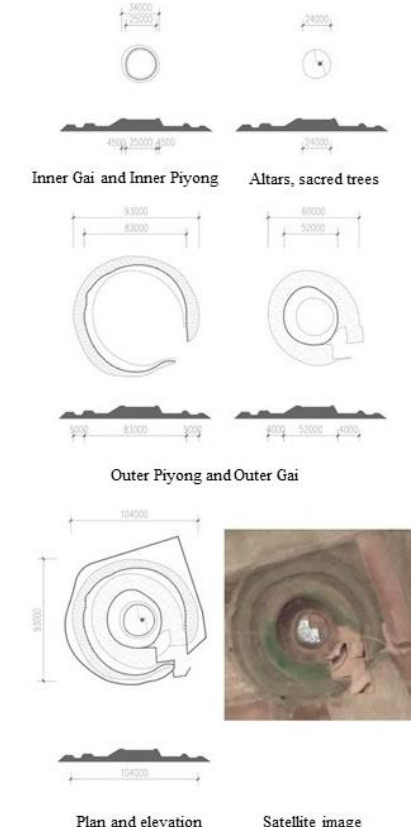
Figure 2. Plan, elevation, and building structure of the Round Mound at the